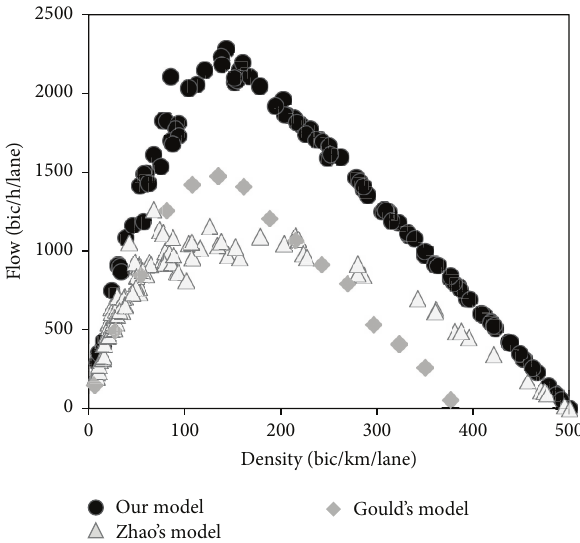
Figure 7: Simulation of number of lane